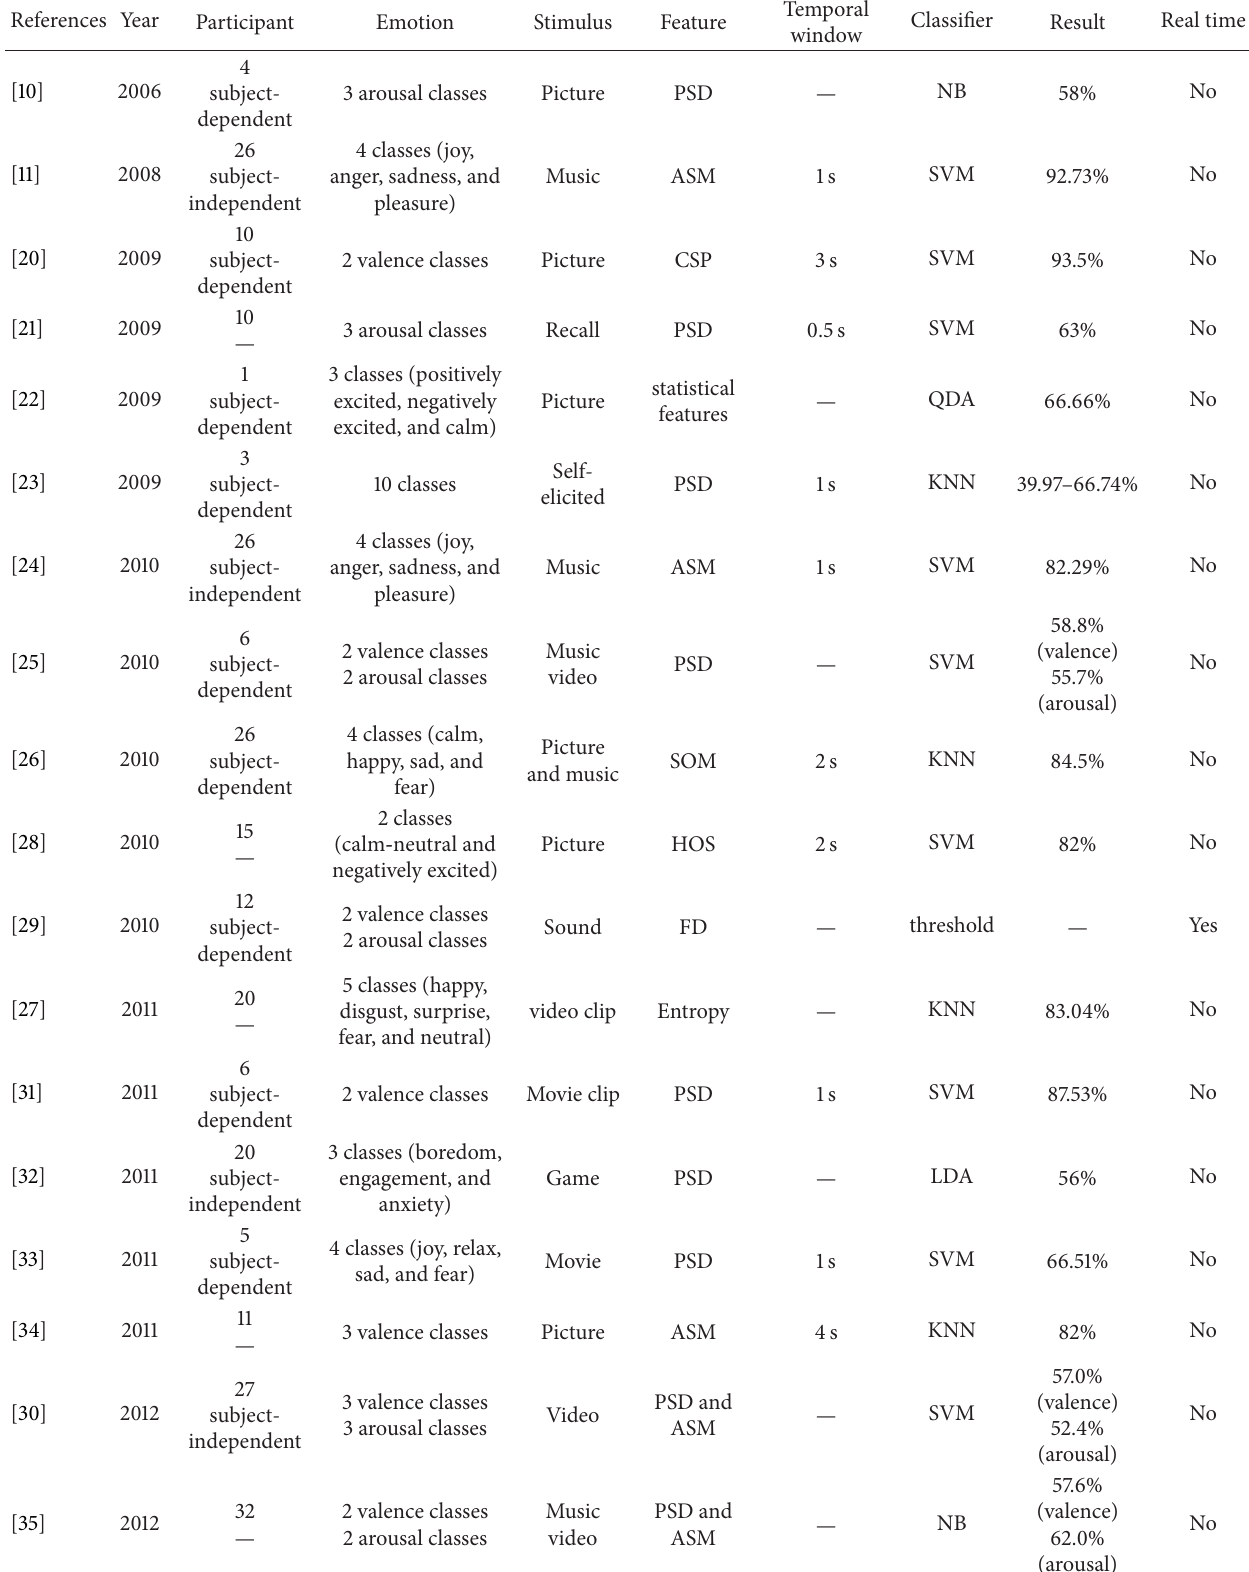
Table 1: EEG-based emotion recognition